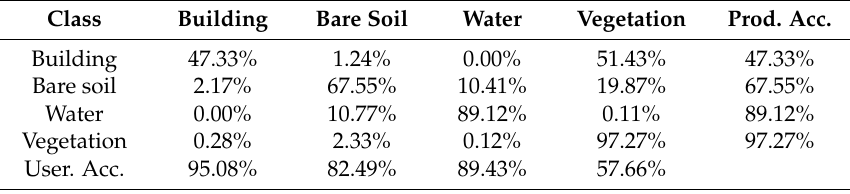
Table 1. Confusion matric of the MCSM-SVM classification result.